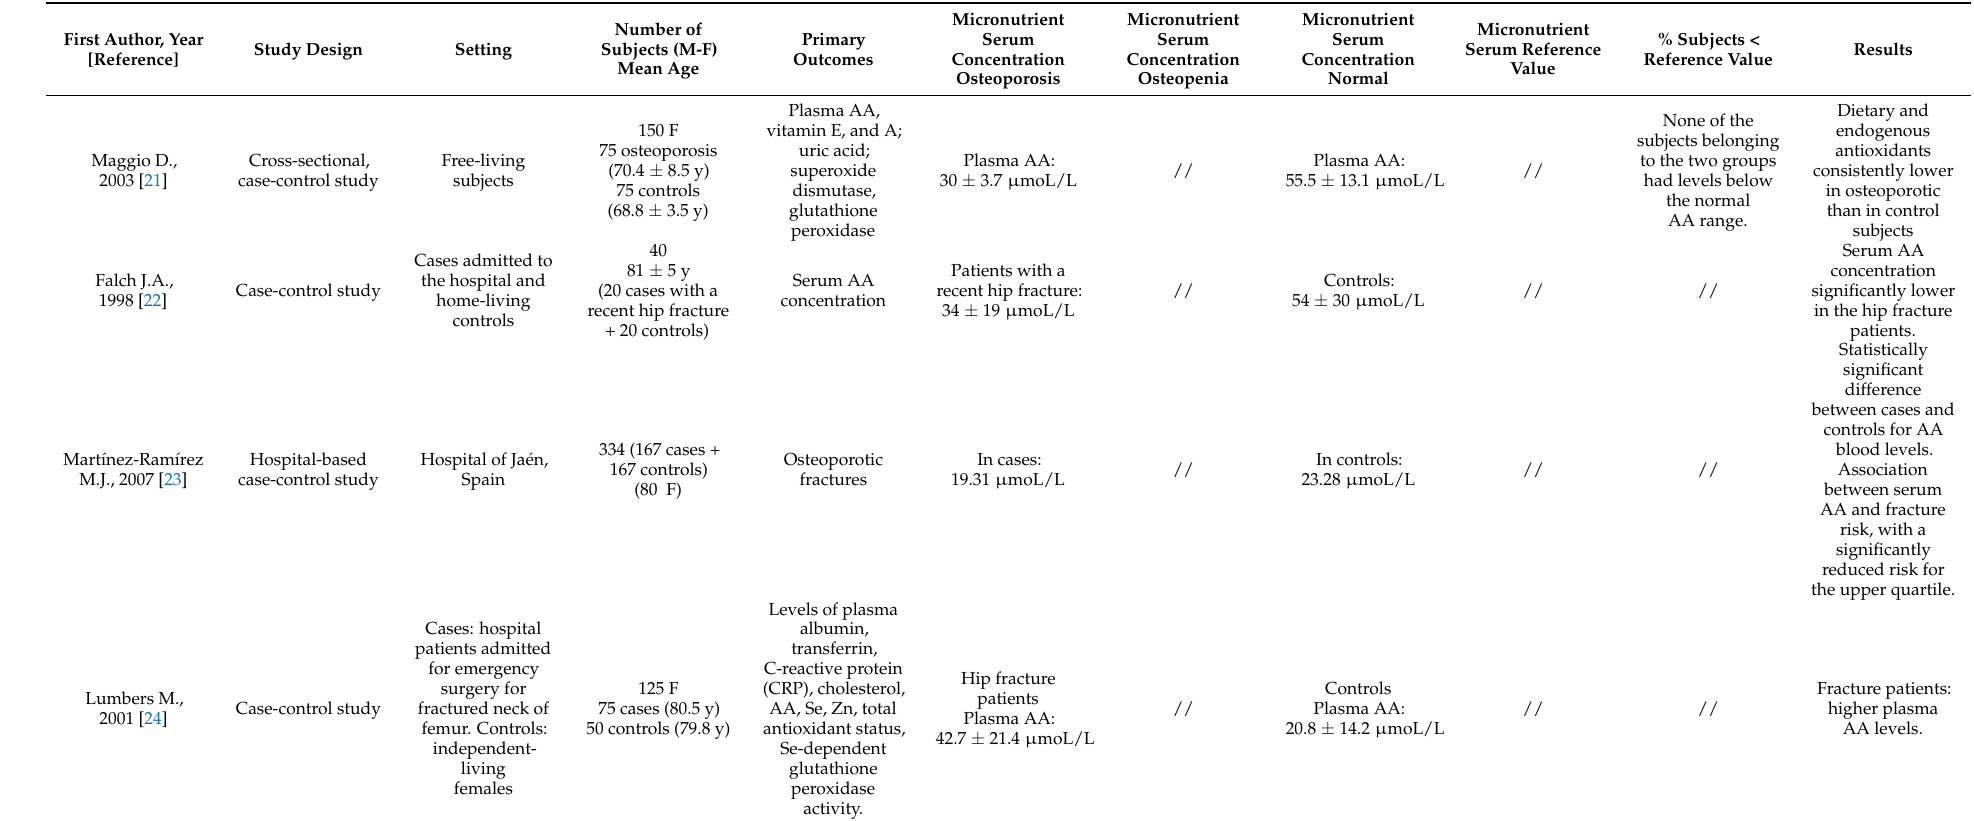
Table 2. Studies that considered blood ascorbid acid (AA)